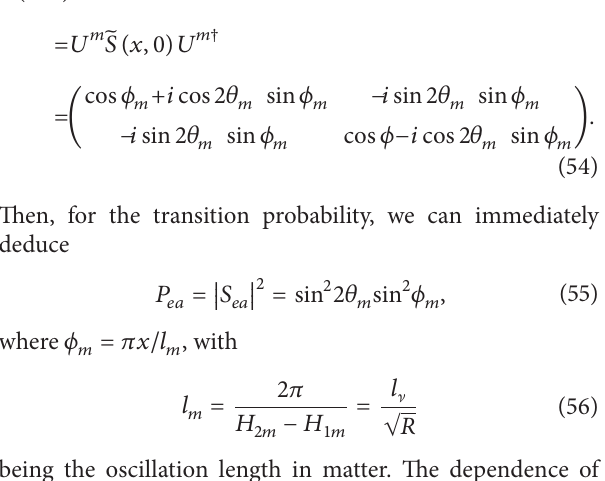
the same holds for ] 𝛽 . The third and fourth equations